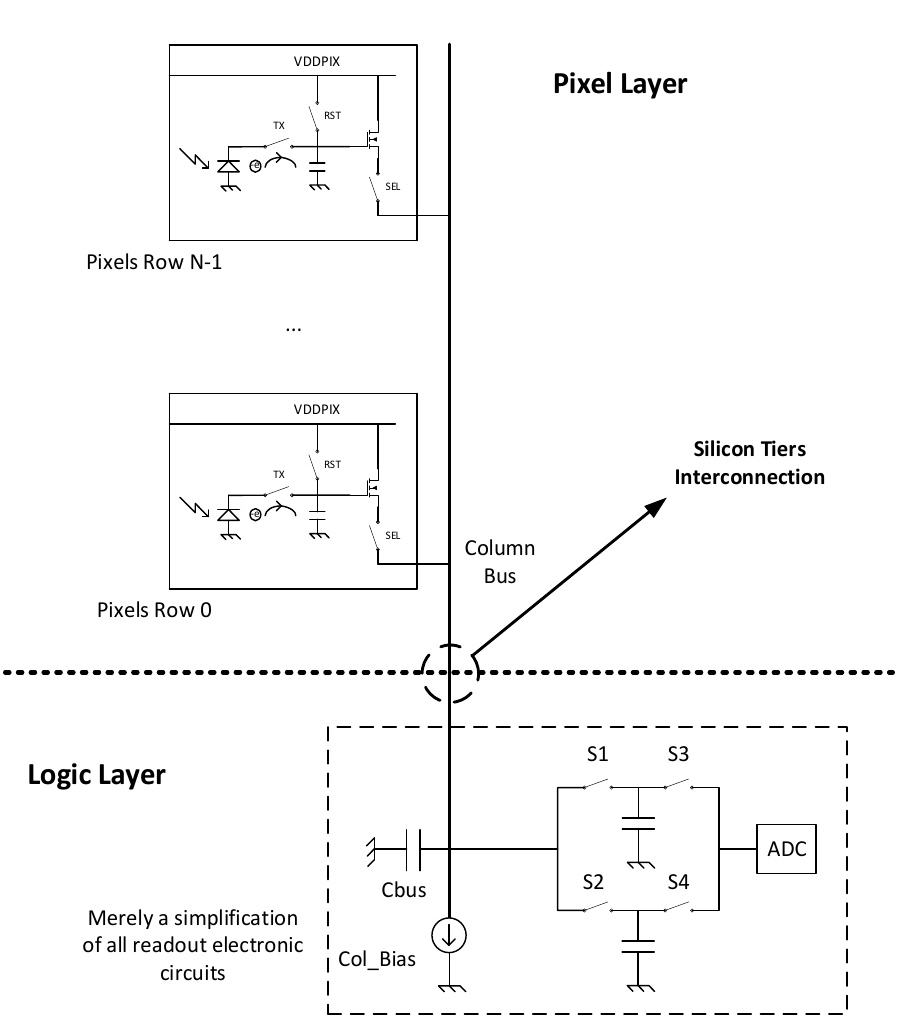
Figure 4. Example of the top-bottom silicon tiers circuits’ interconnection, accommodating (for the example case) 4T pinned-pixels.